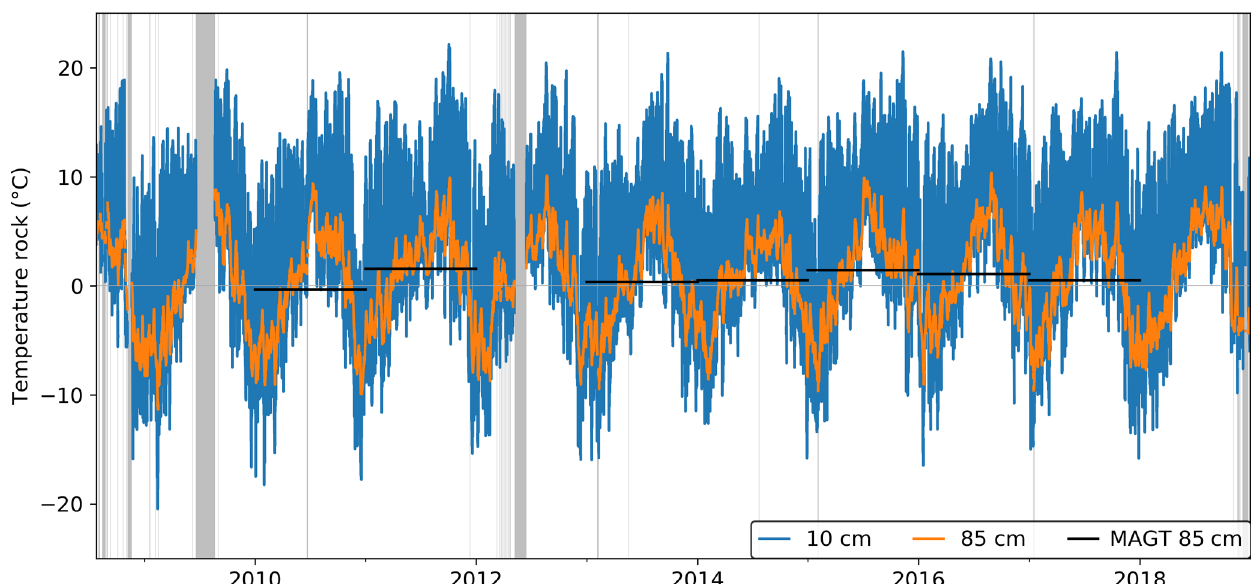
Figure 8. Rock temperature measured at different depths at position MH10. Black lines indicate mean annual rock temperature at 85cm depth, if at least 98% of the data are available. Gray bars indicate data